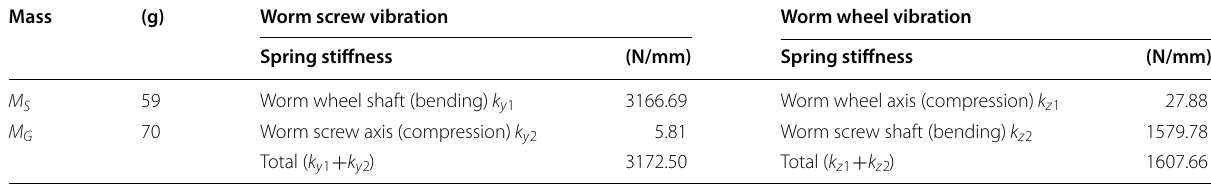
Table 2 Weight of the worm screw and wheel and spring stiffness of each shaft